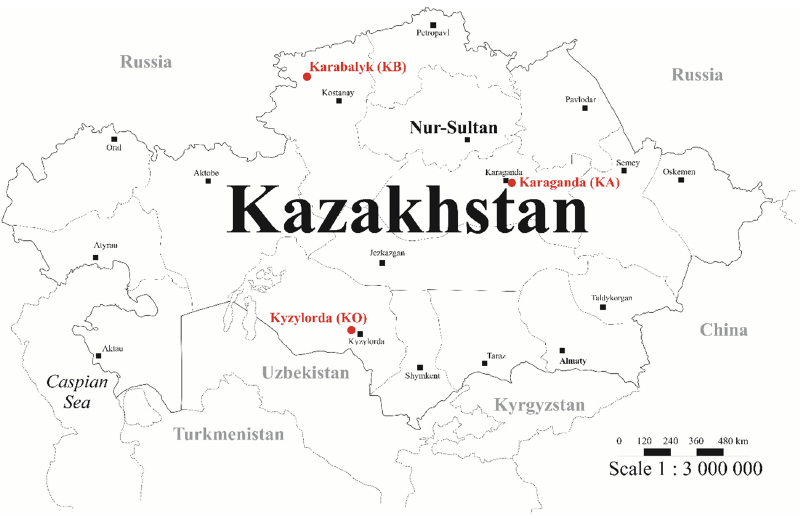
Figure 1. Geographical locations of three experimental stations. KB — Karabalyk Agricultural Experimental Station; KA—Karaganda Agricultural Experimental Station; KO—I. Zhakhaev Kazakh Research Institute of Rice Growing (Kyzylorda).